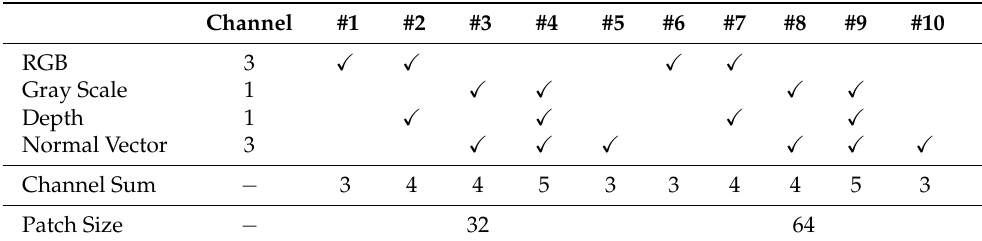
Figure 9. Examples of normal maps. Table 1. Input